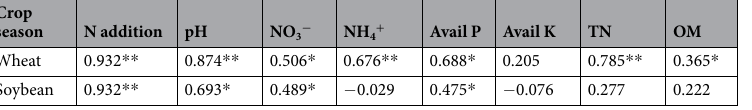
Table 1. Mantel test of UniFrac distances with soil properties and N addition in two seasons. Avail P indicates available phosphorus, Avail K is available potassium, TN is total N and OM is organic matter. * P < 0.05; ** P <